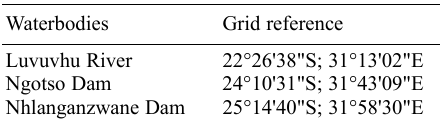
Waterbodies of the Kruger National Park surveyed for the first time in 2001 and in which no molluscs were